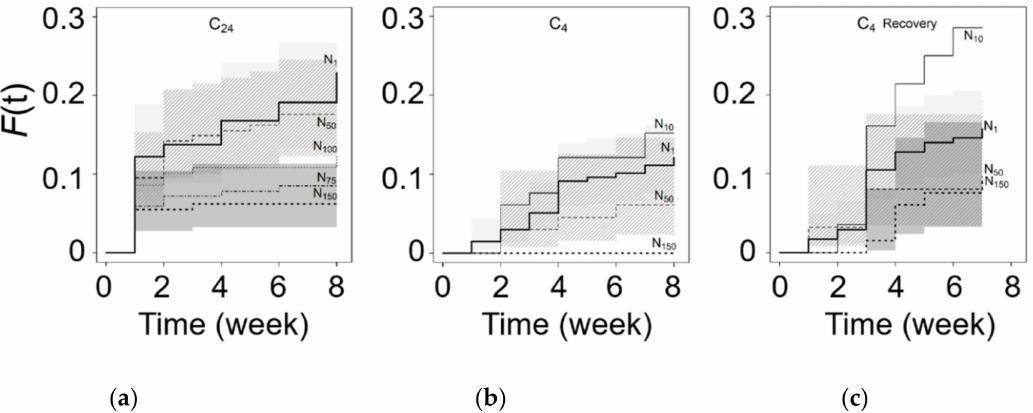
Figure 3. Cumulative germination probability, F (t), for di ff erent salinity (Nx; x = NaCl in mM) during germination ( a , b ) and recovery ( c ). Mean ± 95% confidence interval (CI) bands for N 1 (light gray), N 50 (diagonal stripes) and N 150 (dark gray). Same symbols in all plots.